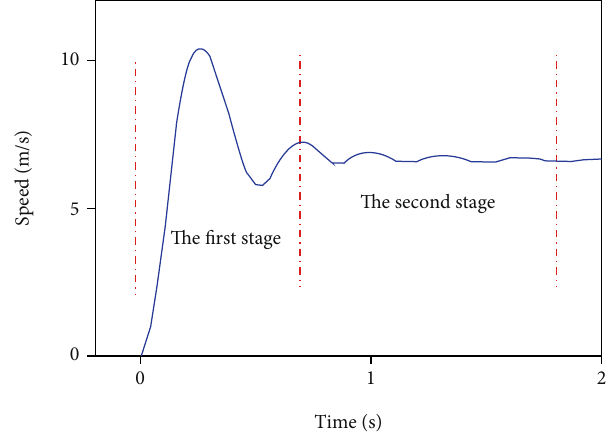
Figure 3: Magni fi cation curve of the fi rst and second stage characteristics of transient coupled fl ow in